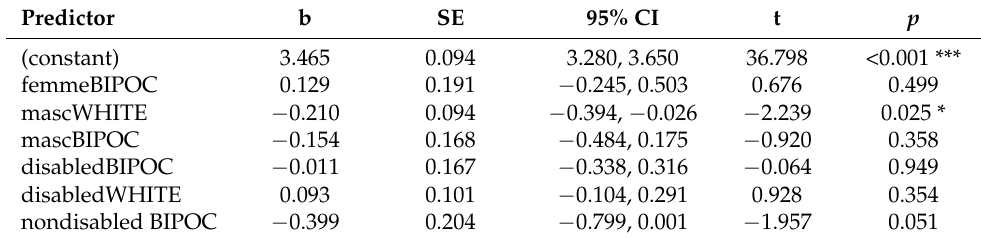
Table 9. Predicting COVID-19 impact by intersecting